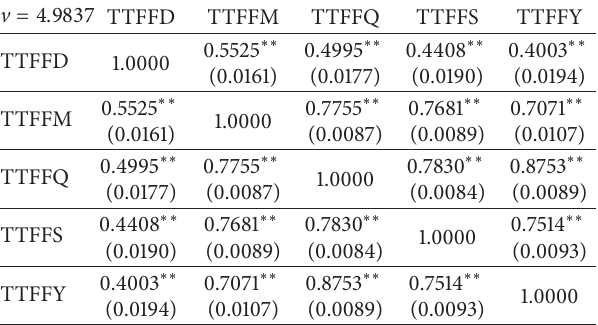
Table 6: Estimated parameters of natural gas portfolio for the multivariate Student 𝑡 -copula.